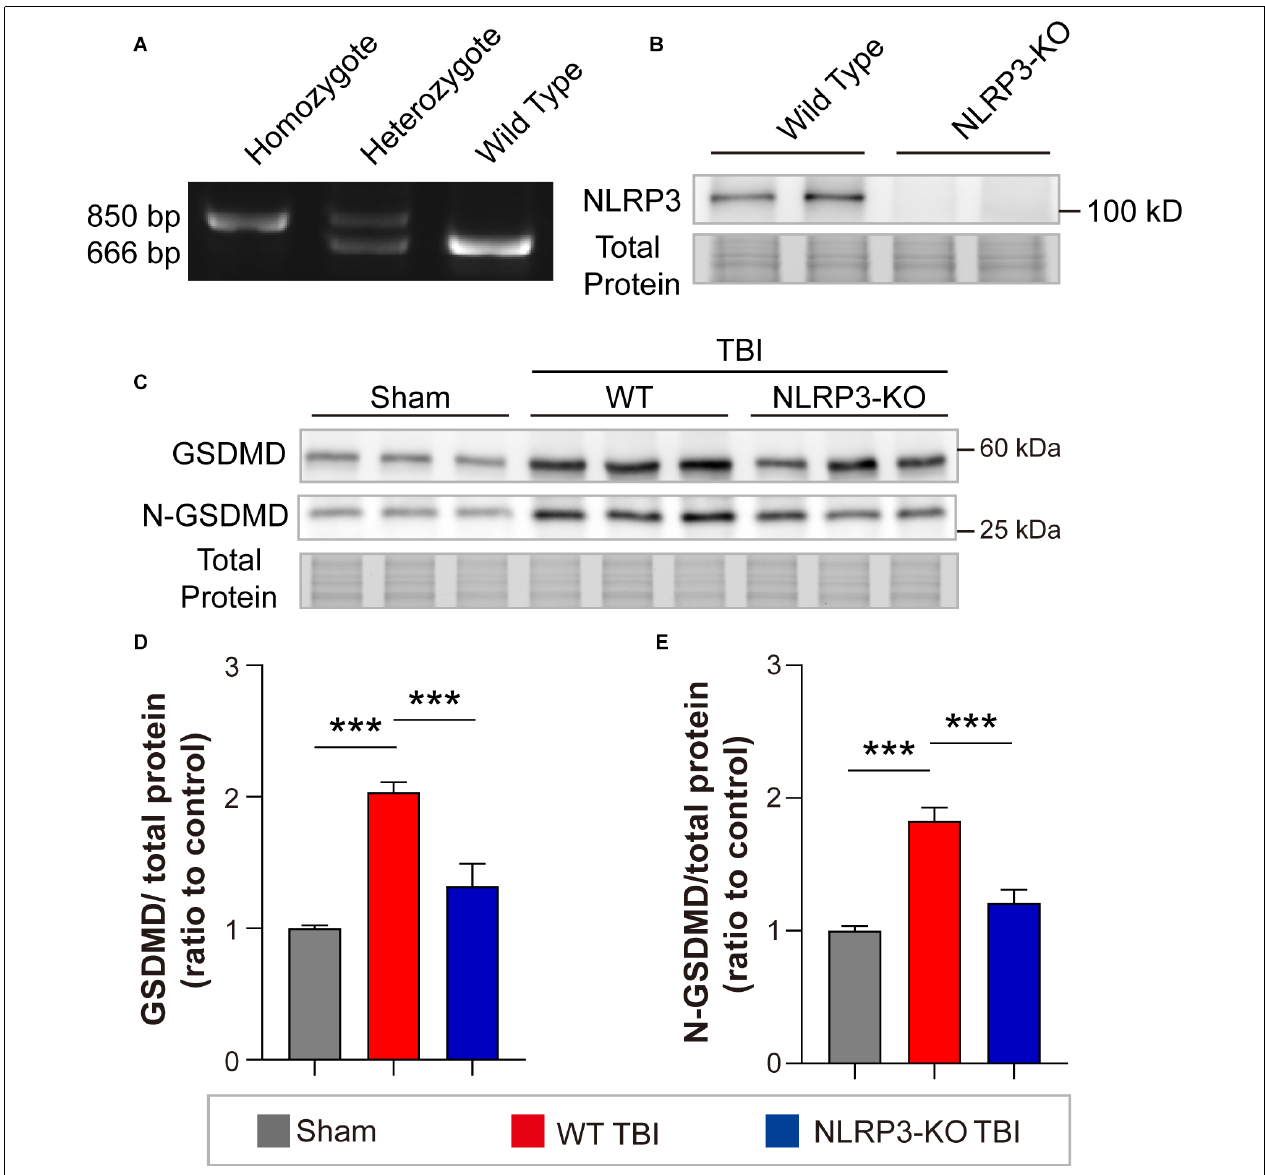
FIGURE 6 | NLRP3-KO inhibited the expression and cleavage of GSDMD at 3 days after TBI. (A) Representative images of agarose gel electrophoresis for NLRP3-KO mouse genotyping. (B) Representative images of immunoblots for NLRP3 using brain samples from WT mice and NLRP3-KO mice. (C) Representative images of immunoblots for GSDMD, N-GSDMD, and total protein. (D,E) Quantitative analysis of GSDMD and N-GSDMD levels ( n = 6). All data are presented as the mean ± SEM and were analyzed using one-way ANOVA followed by Tukey’s multiple comparisons test for significance. *** p <